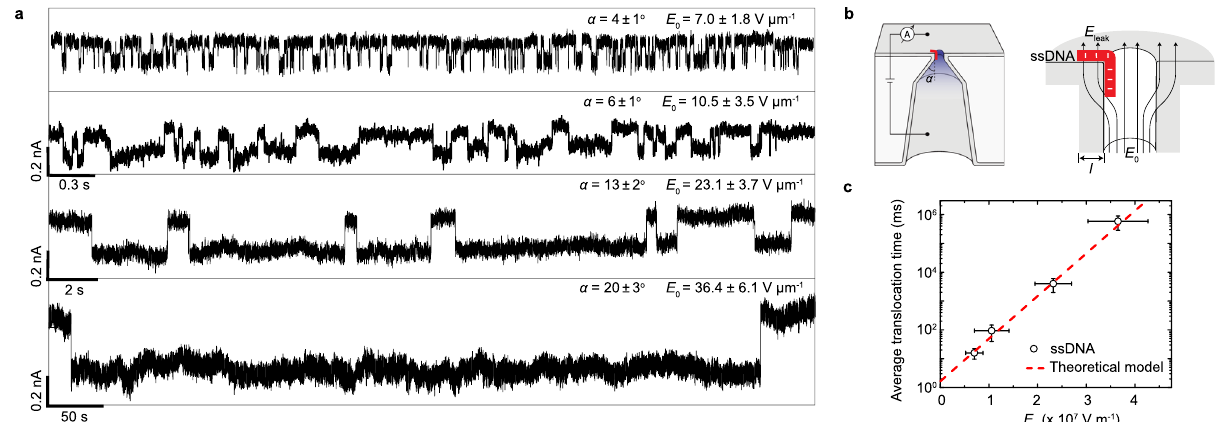
Fig. 4 Modulation of translocation dynamics by angle control. a Representative current traces of 22 nt ssDNA translocating through four bullet-shaped Al 2 O 3 -coated (thickness, 3 nm) nanopores (diameter, 10 nm) with different half cone angles ( α ). The nanopores with larger cone angle allow more electric fi eld ( E 0 , as indicated) to be focused at the nanopore tip under the same applied voltage (500 mV) and thus higher magnitude of normal leakage the pore edge. With the increase of half cone angle and thus normal leakage fi eld, the average translocation time can be increased exponentially from milliseconds to hundreds of seconds. b Left: schematic of the measurement apparatus using a bullet-shaped Al 2 O 3 -coated nanopores with half cone angles of α . Right: zoom in of the nanopore ori fi ce with ssDNA electrostatically trapped at the pore edge by the normal leakage fi eld. c The average translocation time dependence of E 0 ( n = 3). Error bars in the fi gure represent the standard deviation between independent experiments. The line represents the fi t of the data to the theoretical model τ ¼ τ 0 e (cid:2) Δ W þ Δ W (cid:3) ð Þ = k B T , where Δ W and Δ W * are given by Eqs. (3) and (4), respectively, with τ 0 = 1.595 ms, a charge per